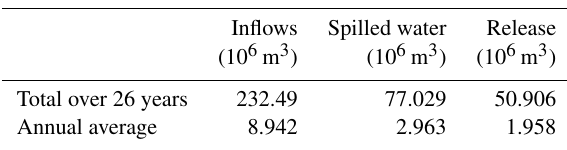
Table 2. Operation of Ghézala dam during period